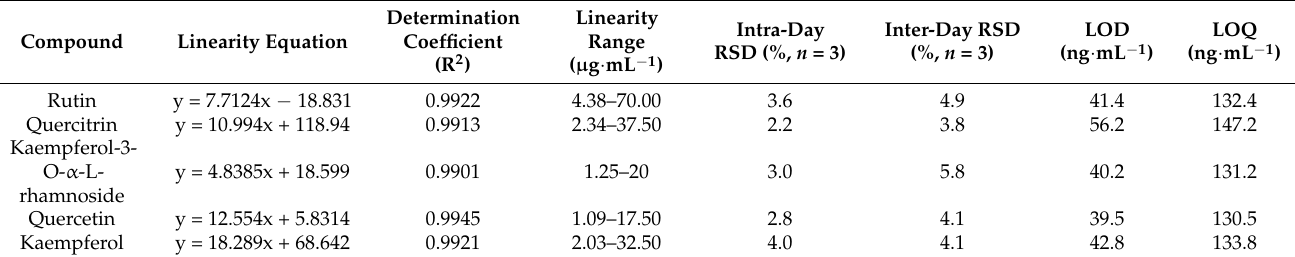
Table 1. Calibration curves, LODs, and LOQs of five flavonoids.